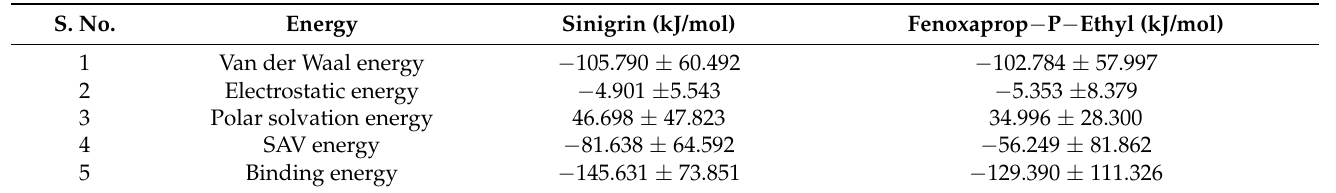
Table 4. Binding free energy analysis of the protein–ligand complexes calculated by MM/PBSA. S.